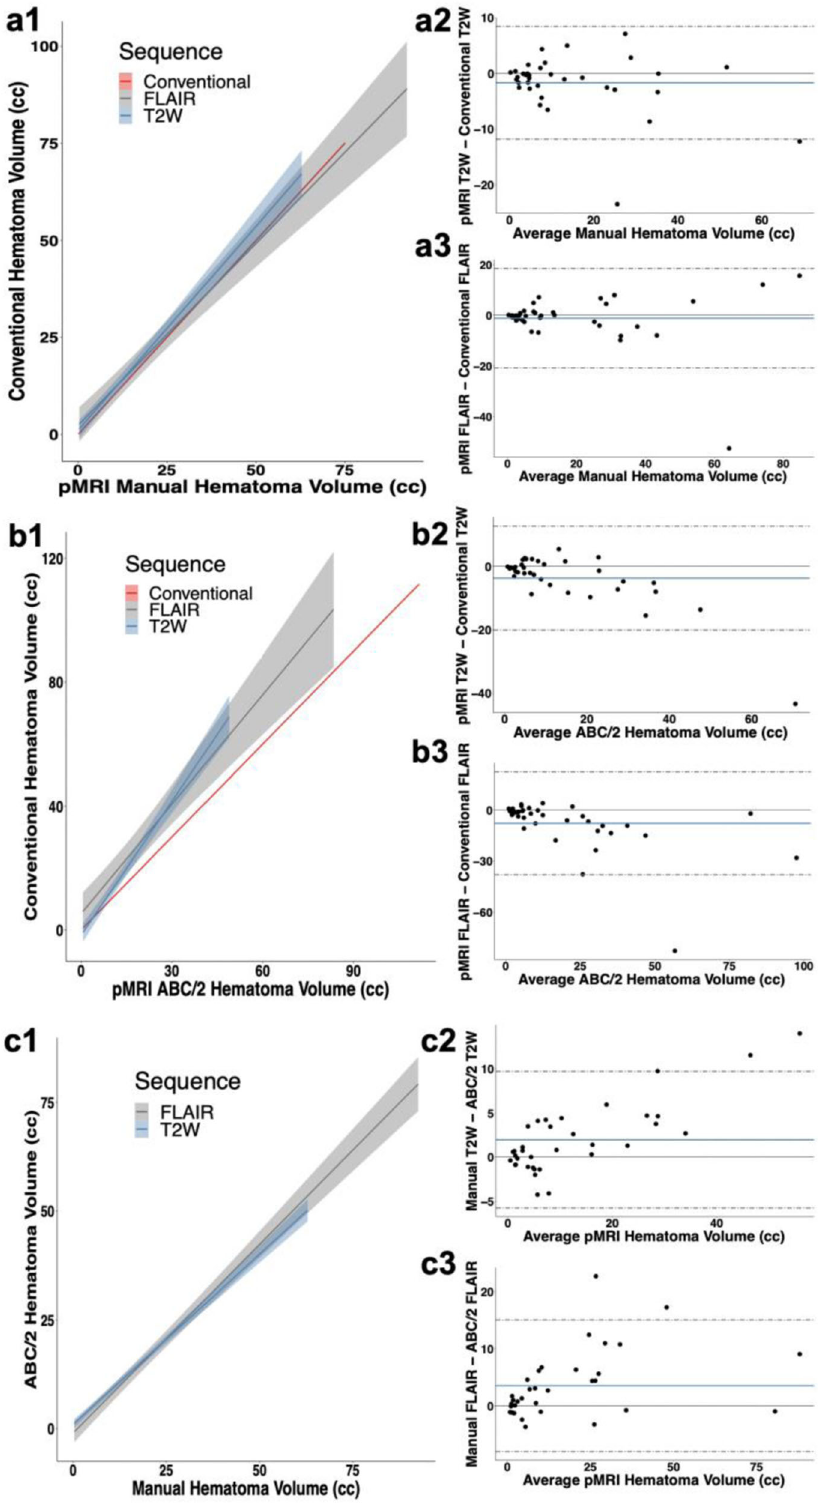
sequences (Fig. 4c2) and a bias of 1.79 cc [95% CI: 0.695 – 2.89] with limits of agreement from − 4.46 cc [95% CI: − 6.35 to − 2.57] to 8.04 cc [95% CI: 6.15 – 9.94] for pMRI FLAIR